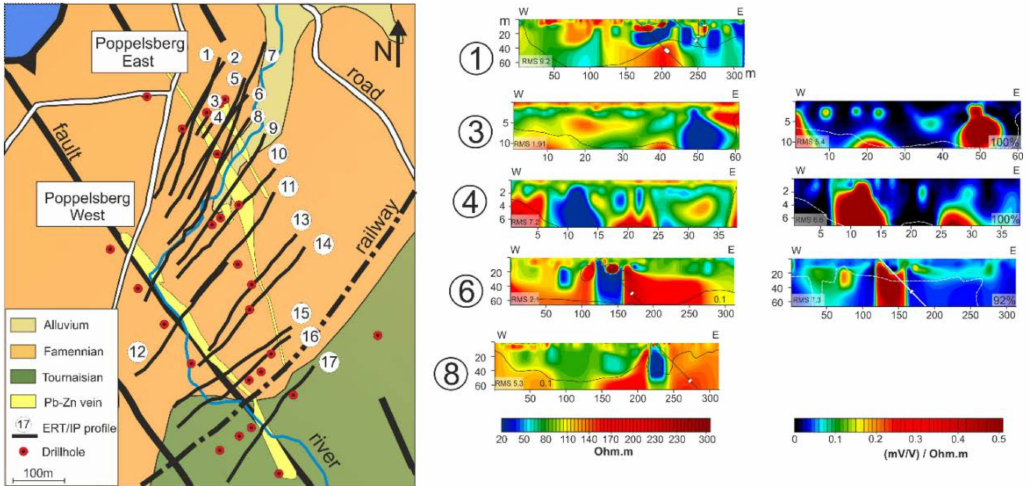
Figure A1. On the left: Resistivity results showing DOI 0.1 isolines and drillholes. The rectangles on the drillings represent mineralized area. On the right: IP profiles (normalized chargeability) displaying drillings and mineralized area. Rectangles represent the thickness and location of the Pb–Zn mineralization. The percentage on the right of each profile indicates the proportion of remaining data after data selection (see Figure 4). The white dashed lines represent the DOI limit corresponding to a value of